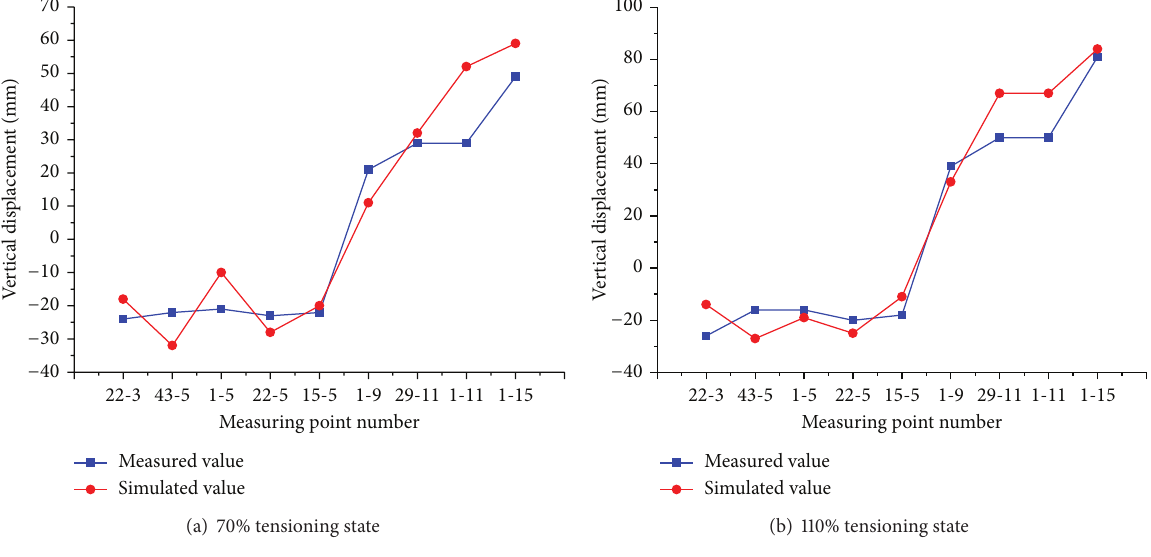
Figure 20: Joint